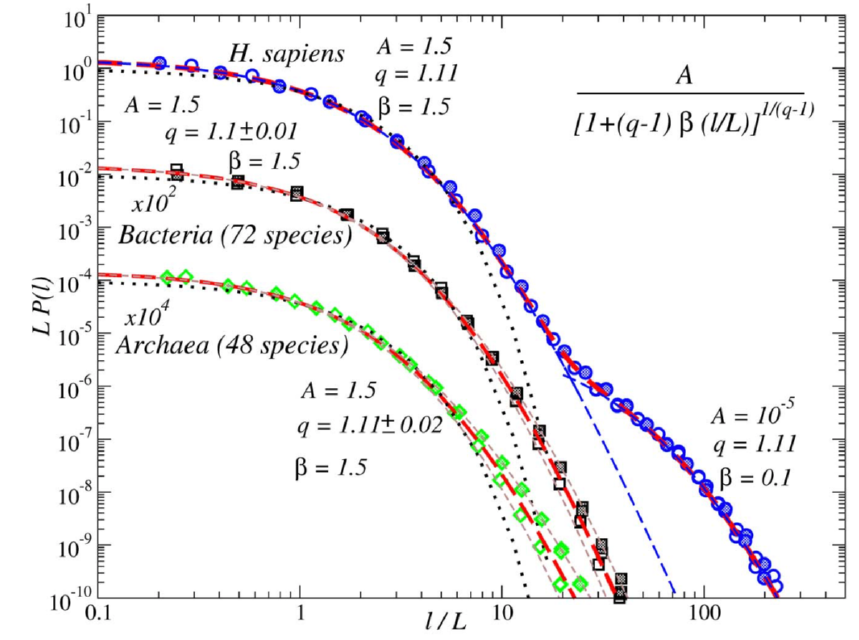
Figure 23. PDFs of the inter-nucleotide intervals A-A, T-T (open symbols); G-G, C-C (full symbols) in the DNA sequences from Homo Sapiens and Bacteria full genomes (in scaled form). Dashed lines show the best fits by a q -exponential distribution A = 1/ [ 1 + ( q − 1 ) β ( l / L )] approximation by a single q -exponential with q ∼ 1.1 and β ∼ 1.5 is possible, in H. Sapiens, a sum of two q -exponentials with q ∼ 1.11 and β ∼ 1.5 and 0.1 makes the best fit. To avoid overlapping, the PDFs for Bacteria are shifted downwards by two decades. For comparison, dotted lines show corresponding exponential PDFs. From